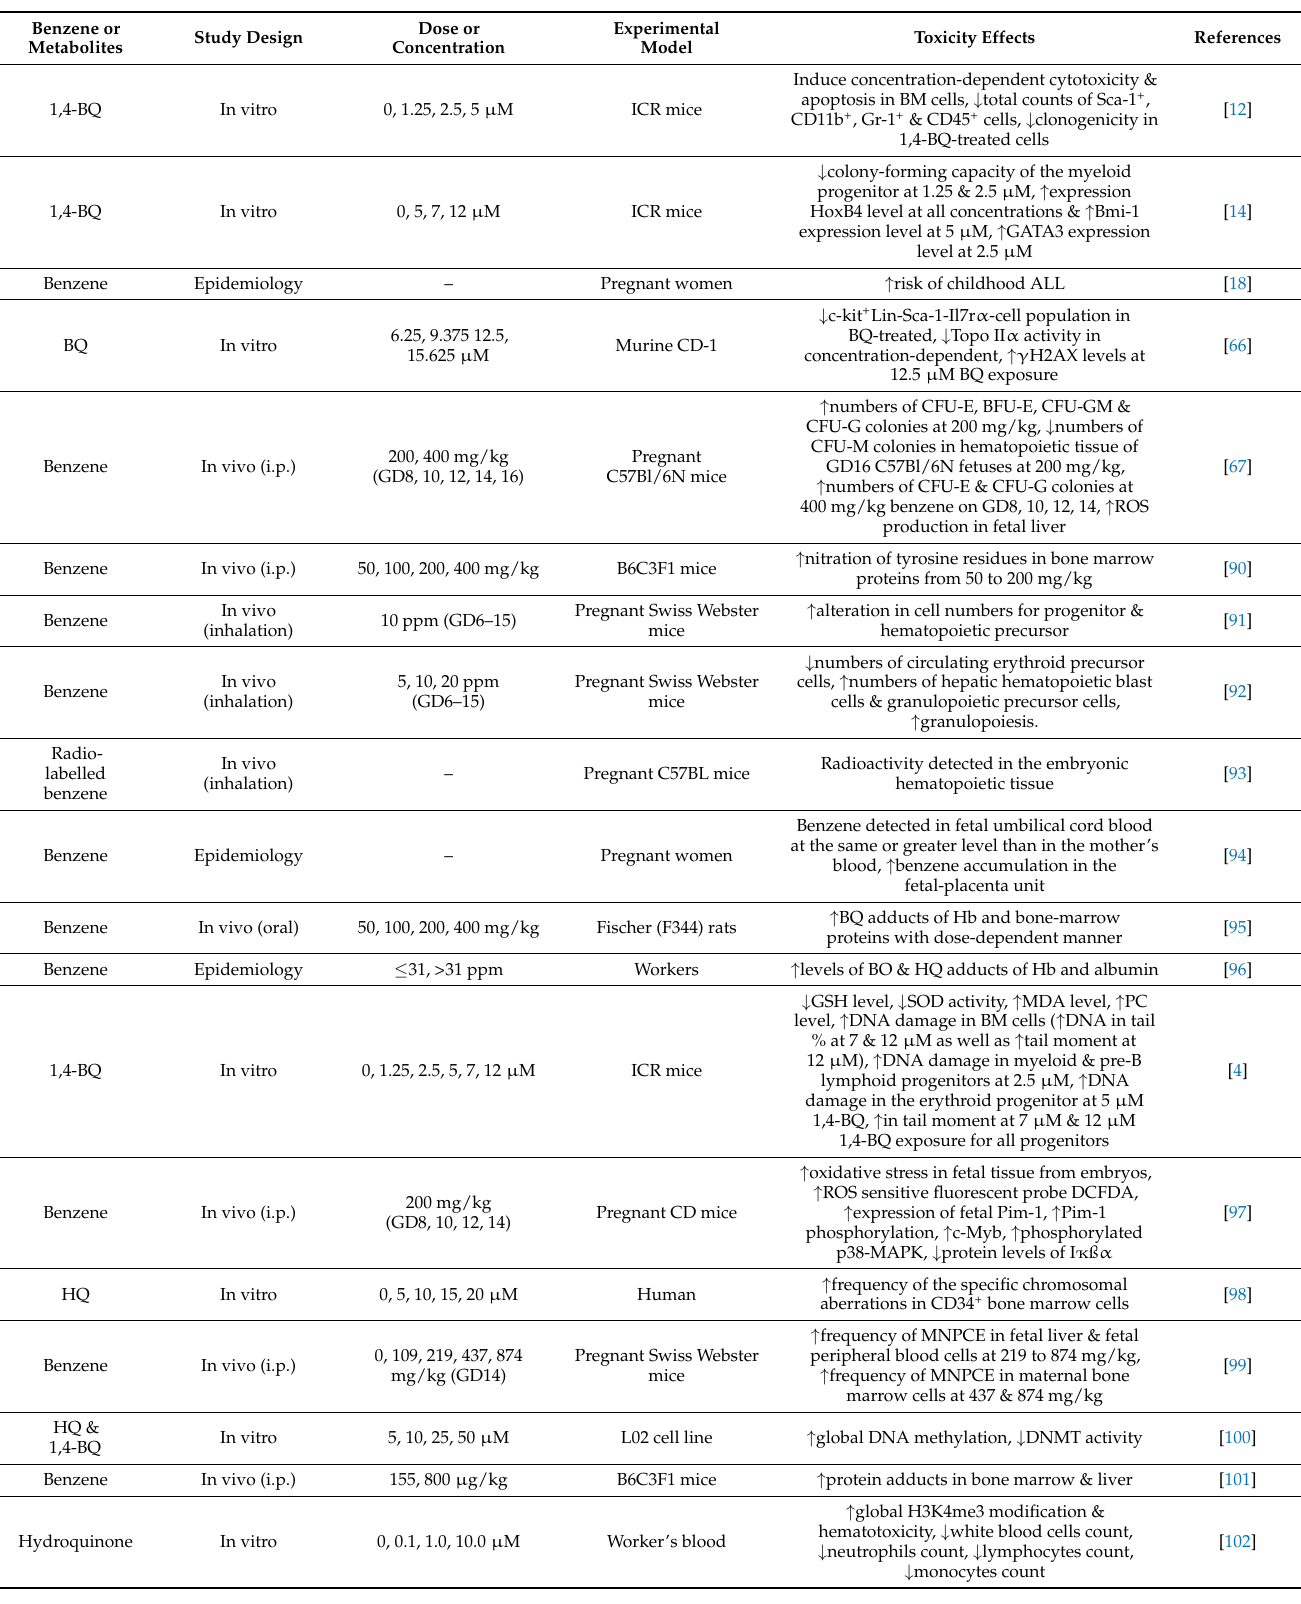
Table 4. Toxicity effects of benzene exposure on various experimental models.